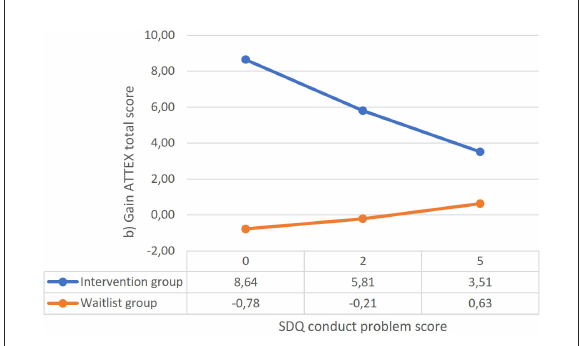
FIGURE2 The linear connection between conduct problem symptoms and teacher-rated gain in the CC score (process analysis; Hayes, 2018). Statistically significant area of difference 0.00–3.20 for the ATTEX CC score on the SDQ conduct problem